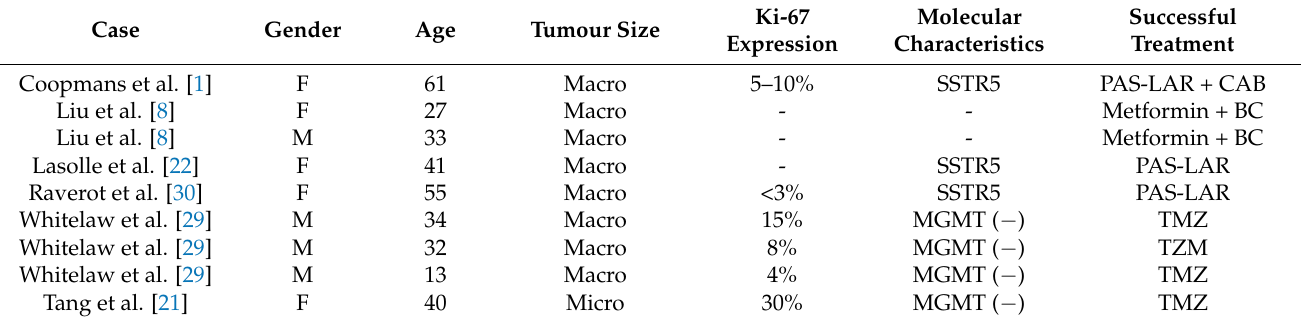
Table 1. Clinical and molecular characteristics of eight patients with DA-resistant